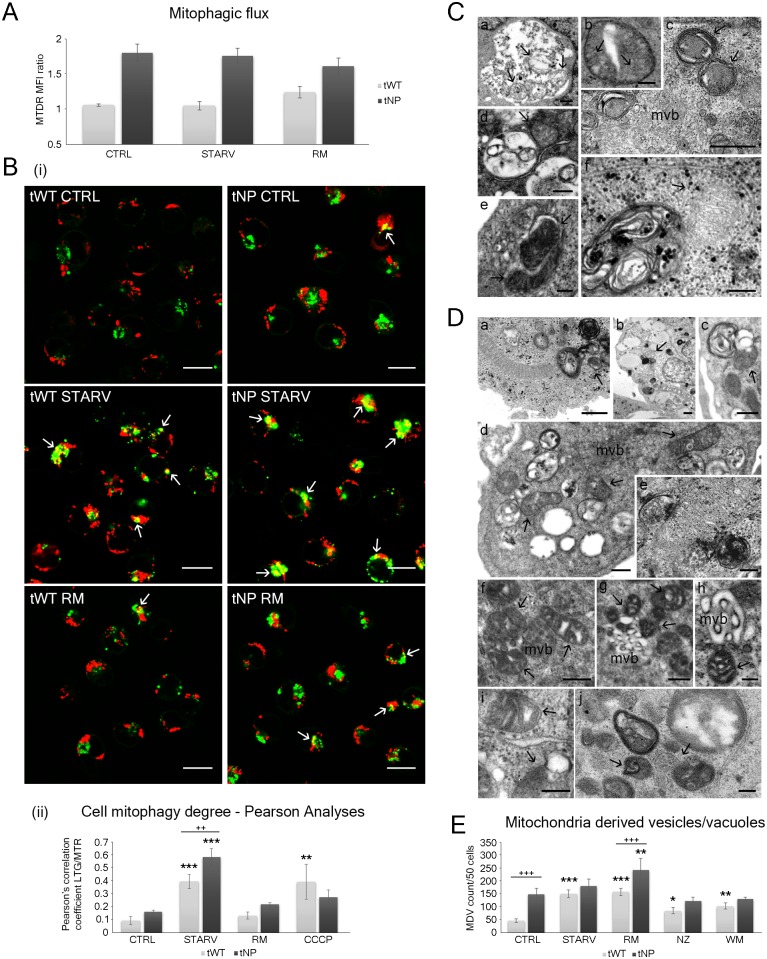
Mitochondrial autophagy evaluation by confocal and electron microscopy.(A) Mitophagic flux for control, starved and rapamycin-treated cells. For each experimental condition, MTDR fluorescence was measured in the presence or absence of chloroquine (CQ). Each value is expressed as the ratio of MTDR mean fluorescence intensity (MFI) in the presence of CQ to that in the absence of CQ. The difference between cell lines was determined to be significant by two-way ANOVA (***P < 0.001). (B) Evidence of mitophagy type 1/2 (classic mitophagy) in confocal microscopy. (i) Single confocal optical sections (~0.8 μm thickness) showing overlay of LTG (green) and MTR (red) in wild-type and pathologic samples for control, starved and rapamycin-treated cells. White arrows represent the LTG-labeled acidic organelles colocalizing with MTR-labeled mitochondria. Bars: 10 μm. (ii) Pearson's colocalization coefficient (PCC) of LTG and MTR for control, starved and rapamycin-treated cells. The uncoupling agent CCCP was used as a positive control. Pearson's coefficients were derived from three completely independent experiments with >10 fields per experiment contributing to the cumulative result. Each value is expressed as PCC ± SD; **P < 0.01 and ***P < 0.001 vs respective control. Two-way ANOVA with Bonferroni post test revealed a P value < 0.01 (++P < 0.01) between tWT and tNP starved cells. (C) TEM evidence of mitophagy type 1/2 (classic mitophagy) in Niemann-Pick cells in control condition (a), after nutrient deprivation (b, c) and rapamycin administration (d, e, f). In NP samples, mitochondria were recognizable within autophagic vacuoles (black arrows). Mvb: multivesicular bodies. Bars: 0.5 μm for a, c, d, f; 0.2 μm for b, e. (D) TEM evidence of mitophagy type 3 (micromitophagy) in normal (a, i) and NP-B B lymphocytes (b-h, j) after rapamycin administration (a-h) and nutrient deprivation (i, j). Black arrows indicate mitochondria-derived vesicles (MDVs) or mitochondria closely linked to autophagic vacuoles. Several of these structures were located right next to lipid droplets (b) and multivesicular bodies (mvb, d, f-h). Bars: 0.5 μm for a, b, d, f, g, i; 0.2 μm for c, e, h, j. (E) Mitochondria-derived vesicles (MDVs) from non-pathological and pathological cells were counted in all experimental conditions. Each value is expressed as an absolute number ± SD (n = 3; 50 cells counted/experiment). *P < 0.05, **P < 0.01 and ***P < 0.001 vs respective control. The difference between cell lines was determined to be significant by two-way ANOVA (***P < 0.001). Two-way ANOVA with Bonferroni post test revealed a P value < 0.001 (+++P < 0.001) between tWT and tNP basal condition and rapamycin-treated cells.